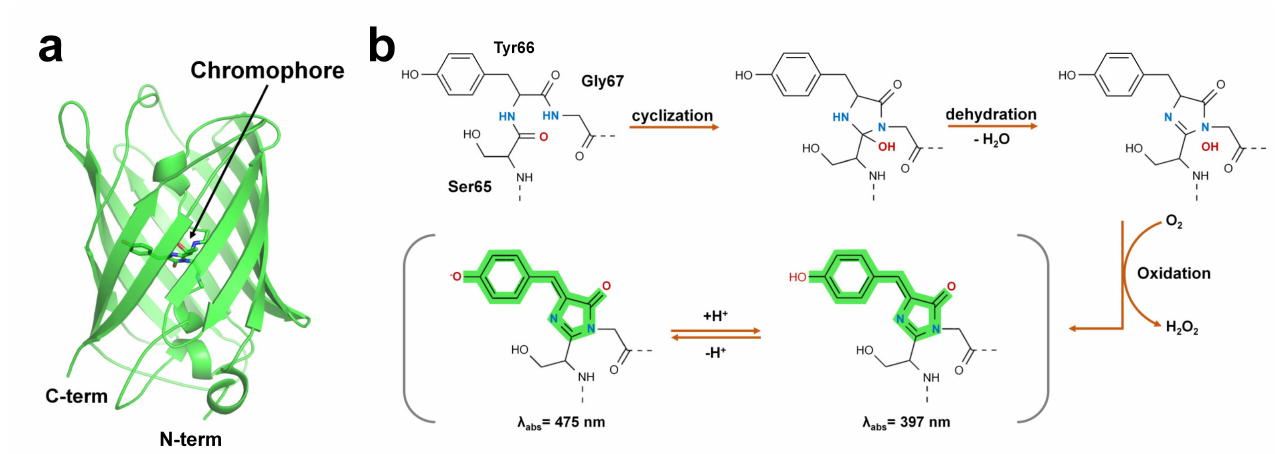
Figure 1. Structure of green fluorescent protein and chromophore. ( a ) Crystal structure of the green fluorescent protein (GFP) from jellyfish (PDB code: 1EMA). ( b ) GFP chromophore